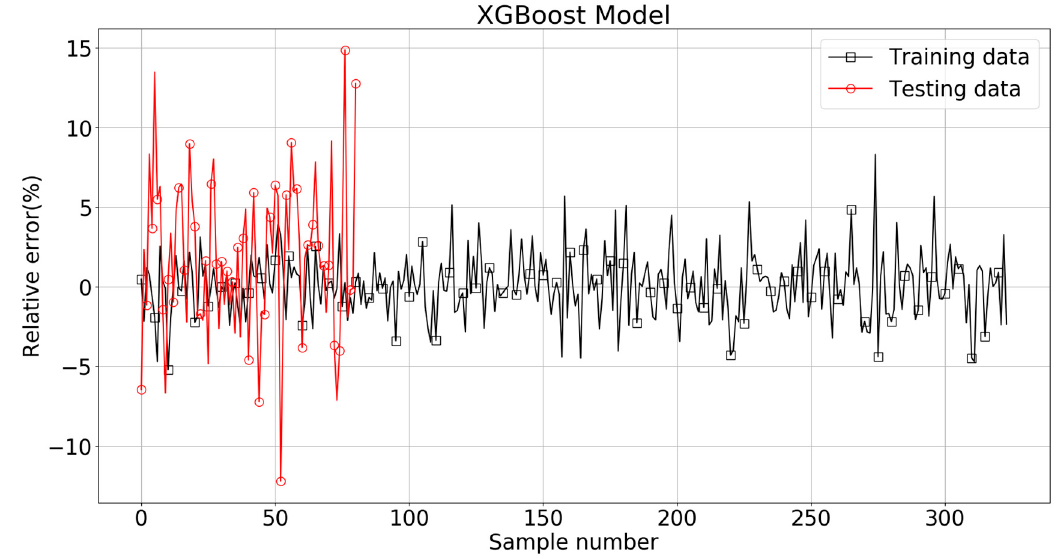
Figure 26. Variation of the relative errors obtained from XGBoost model.